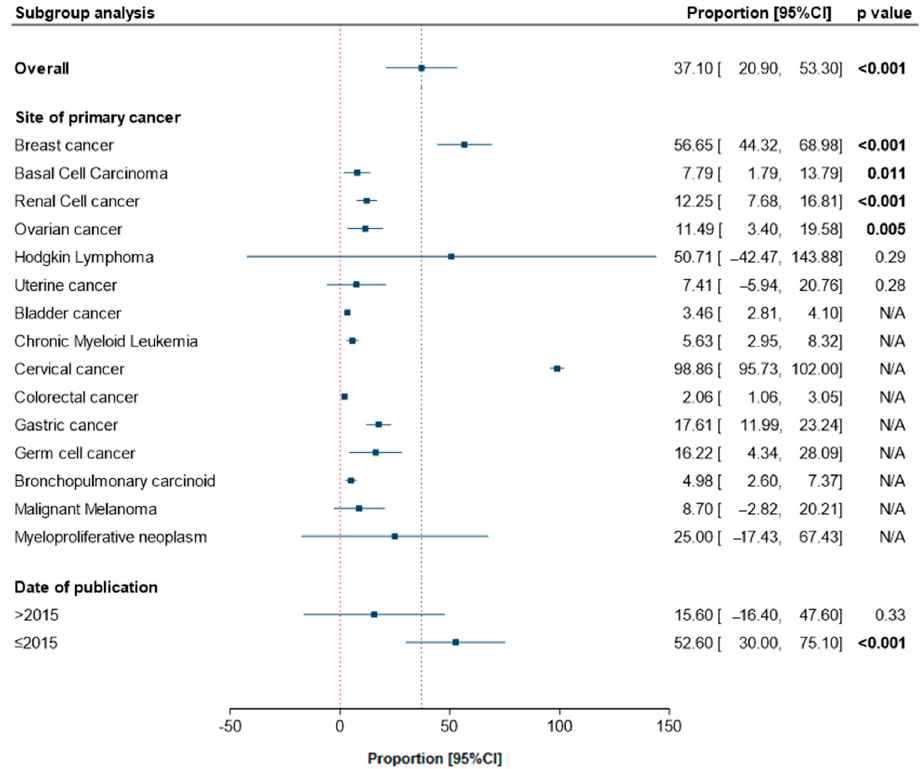
Figure 3 . Categorization of studies by date of publication revealed a high frequency of